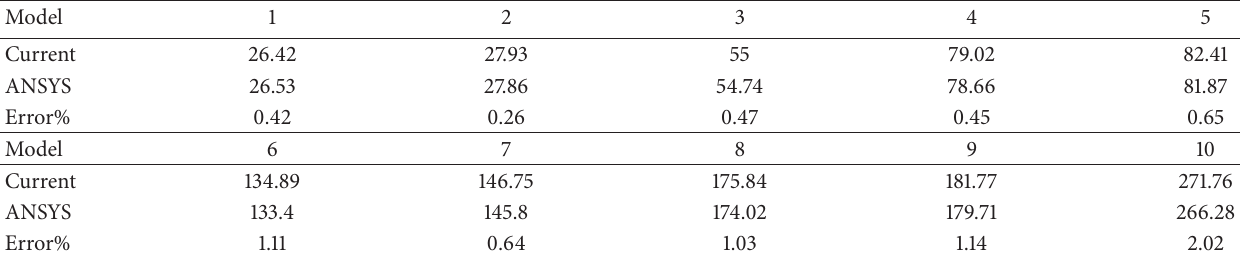
Figure 5: The first eight modes of coupled beams with 90 ∘ coupling angle: (a) the first mode, (b) the second mode, (c) the third mode, (d) the fourth mode, (e) the fifth mode, (f) the sixth mode, (g) the seventh mode, and (h) the eighth mode. Table 7: The first ten natural frequencies of propulsion shafting f/Hz.